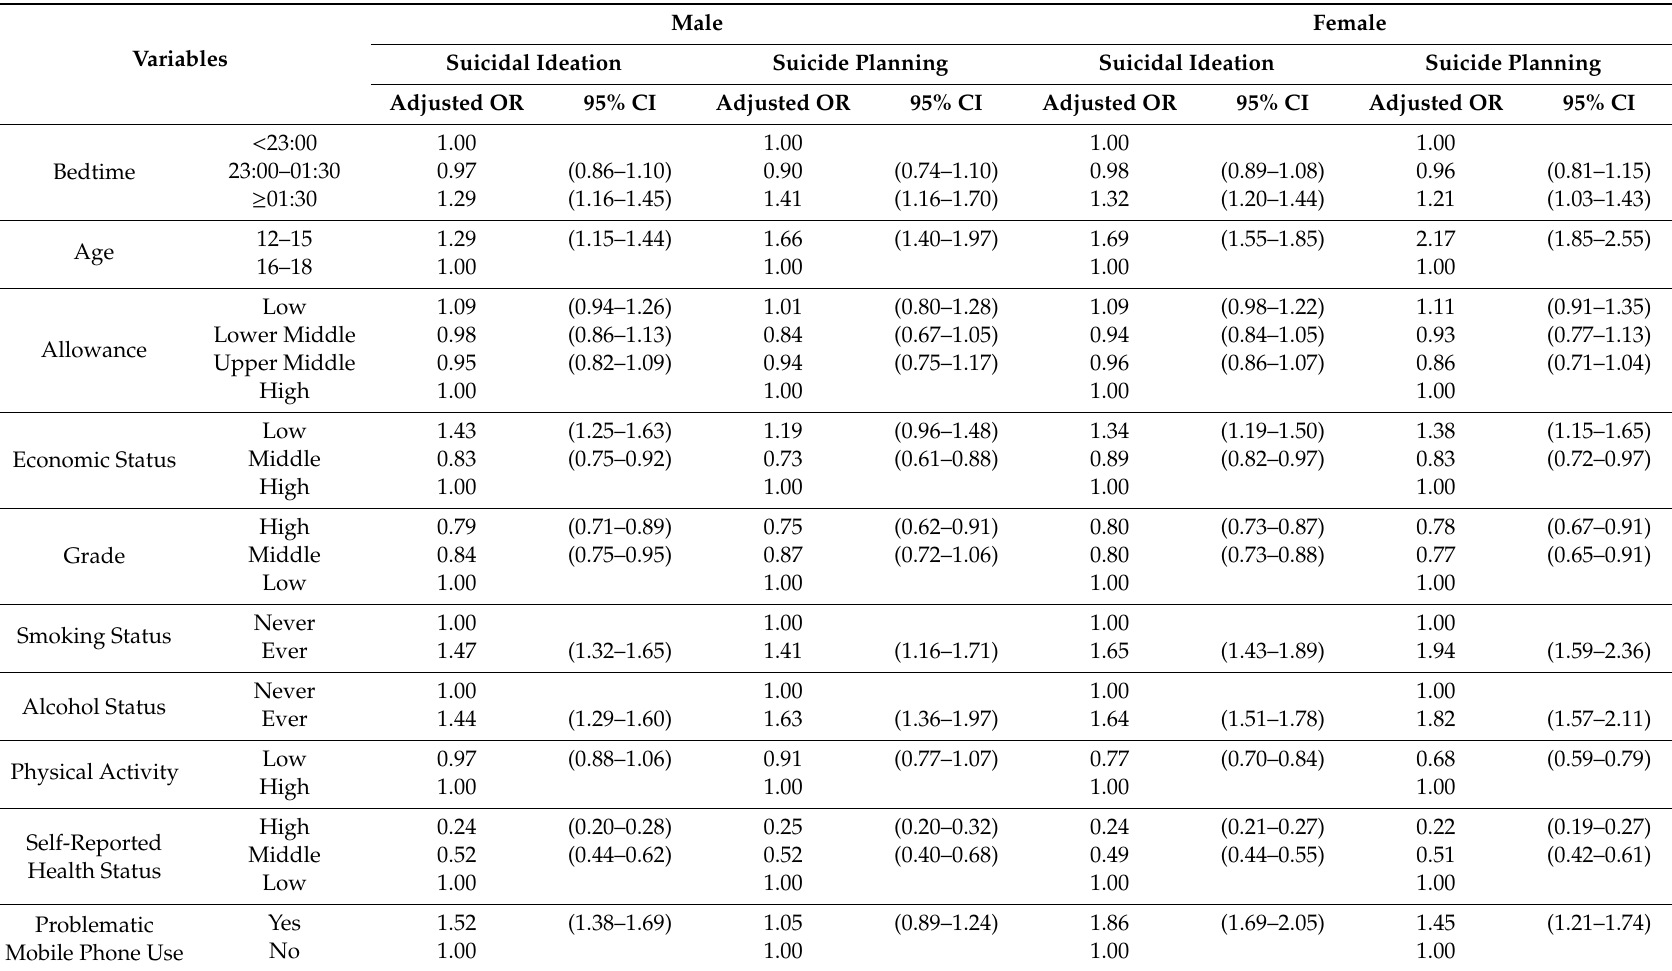
Table 1. Factors associated with suicidal ideation and suicide